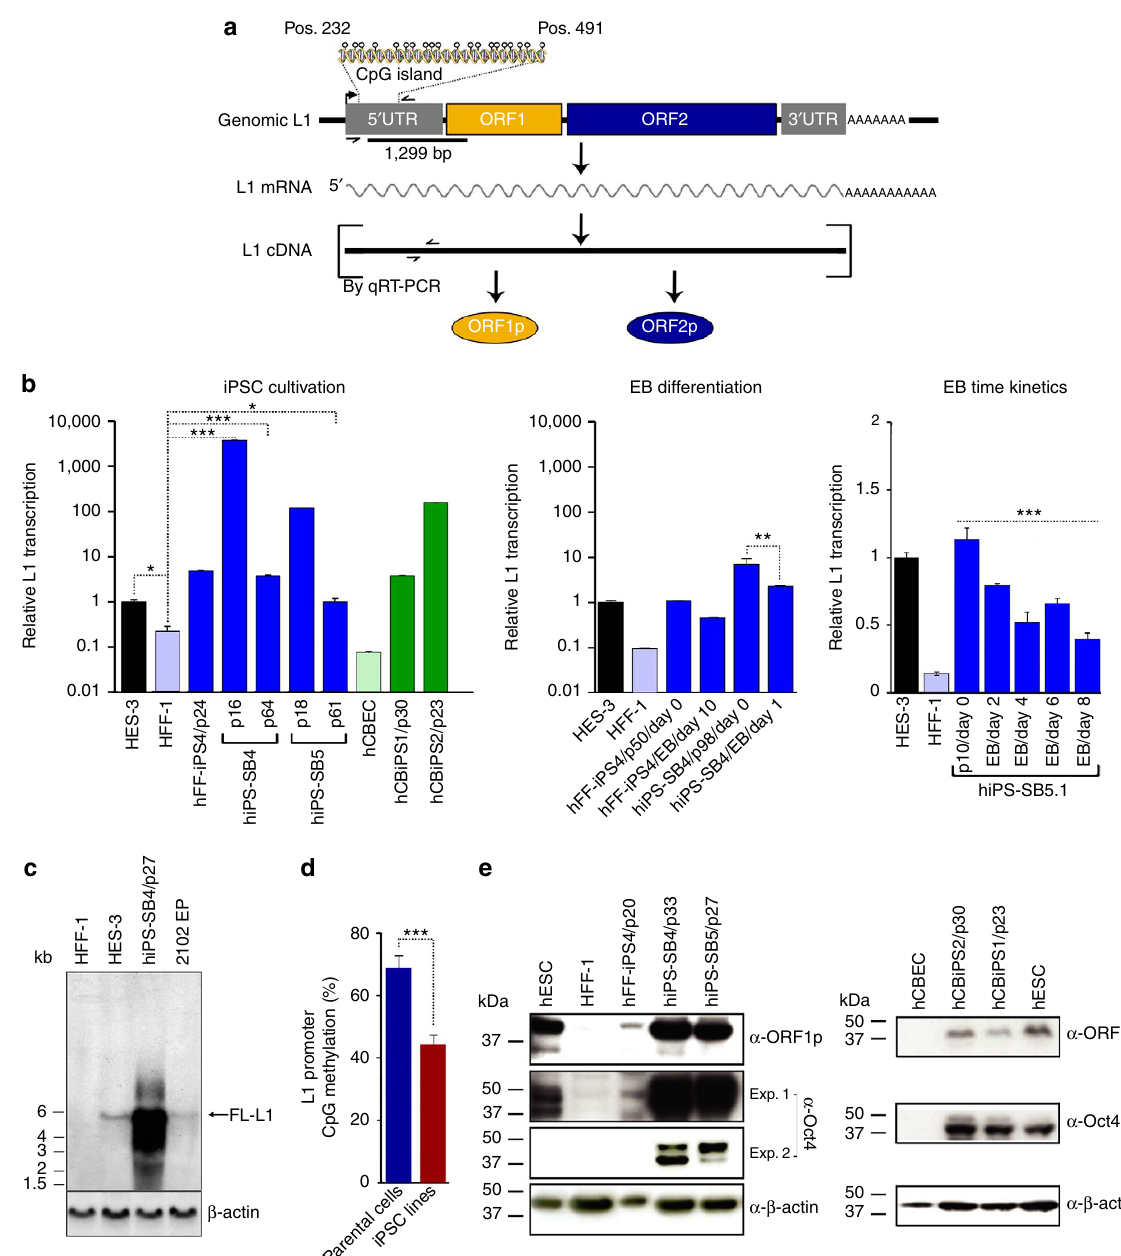
Figure 1 | Reprogramming-induced expression of the L1 retrotransposition machinery is abrogated during embryoid body formation. ( a ) Schematic of organization and expression of a functional human L1 element. Binding sites of TaqMan primer/probe combinations (small convergent arrows) on L1 cDNA used for qRT–PCR analyses and of the 1,299-bp [ a - 32 P]dCTP-labelled PCR product in the 5 0 UTR region (black bar) used for northern analysis are shown. Methylation status of the CpG island (position number 232–491 of the L1.3 reference sequence) was analysed. Open circles, CpG residues. ( b ) Relative full- length L1 (FL-L1) mRNA transcript levels were assessed by qRT–PCR from early passage (until p24) HFF-1-derived (hFF-iPS4, hiPS-SB4 and hiPS-SB5) and hCBEC-derived (hCBiPS1 and hCBiPS1) hiPSC lines (left panel), and after differentiation of hFF-iPS4 (p50) and hiPS-SB4 (p98) lines into embryoid bodies (EBs) (middle panel) (* P o 0.05, ** P o 0.01, *** P o 0.001). hiPS-SB5.1 cells (p10) were differentiated into EBs. L1 transcript levels were quantified on day 0 before initiation of differentiation, and after 2, 4, 6 and 8 days of differentiation by qRT–PCR (right panel; *** P o 0.001, linear regression t -test). Bars represent arithmetic means ± s.d. from experiments performed as technical duplicates of biological triplicates, or, in the case of hCBEC, hCBiPS1 and hCBiPS2 (green bars), arithmetic means of technical duplicates of one biological sample. ( c ) Northern analysis of cytoplasmic poly-A þ mRNA with a 1,299-bp L1 5 0 UTR-specific probe confirmed exceeding activation of FL-L1 transcription during hiPSC cultivation. b -Actin mRNA (1.8kb, lower panel) served as loading control. ( d ) Endogenous L1 promoter sequences are significantly hypomethylated in hiPSC lines relative to their parental HFF-1 and hCBEC cells. Overall percentage methylation of 5 0 UTR CpG islands in HFF-1 and hCBEC cells ( n ¼ 29 CpG islands; blue bar) and in five derived hiPSC lines ( n ¼ 95 CpG islands; red bar), respectively, is presented. Error bars indicate s.e.m.*** P o 0.001; w 2 test. ( e ) Immunoblot analysis of cell lysates from HFF-1 and hCBEC cells and their respective derived hiPSC lines measures L1 ORF1p (40kDa) and Oct-3/4 expression (A isoform, 45kDa; B isoform 33kDa). Shorter (exp.1) and longer exposures (exp.2) of the a Oct-3/4 immunoblot are provided. Lysates from hESC lines HES-3 (left panel) and H1 (right panel) served as positive control for L1 ORF1p and Oct-3/4 expression. b -Actin (42 kDa) served as loading